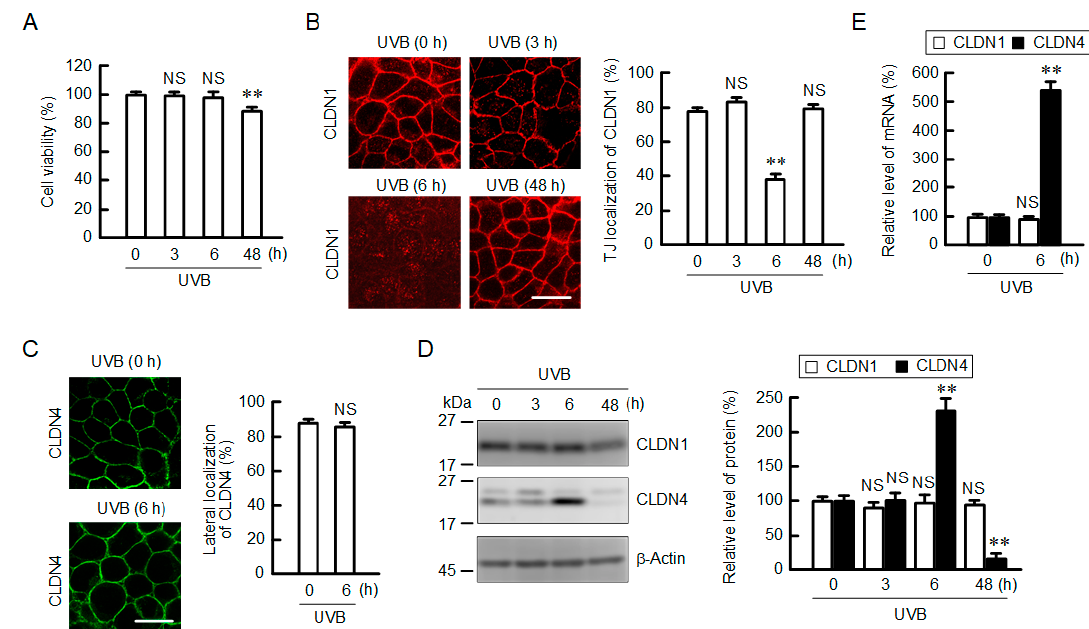
Figure 1. Effect of weak ultraviolet B (UVB) irradiation on cell viability and localization of claudin (CLDN). ( A ) After exposing to weak UVB (5 mJ/cm 2 ), the cells were cultured for 0–48 h. Cell viability was measured using a 2-(4-iodophenyl)-3-(4-nitrophenyl)-5-(2,4-disulfophenyl)-2H-tetrazolium (WST-1) assay. n = 6. (B,C) Cells exposed to UVB were cultured for 0–48 h. The cells were immunostained with anti-CLDN1 antibody ( B ) and anti-CLDN4 antibodies ( C ). Scale bars indicate 10 μ m. The fluorescence values of CLDN1 at the tight junction (TJ) and CLDN4 at the lateral side are shown as a percentage of the total fluorescence values. n = 3. ( D ) Cell lysates were applied to 12.5% SDS-PAGE followed by blotting with anti-CLDN1, anti-CLDN4, and anti- β -actin antibodies. The full-length blot images are shown in Figure S1. The levels of CLDN1 and CLDN4 are represented as a percentage of 0 h. n = 4. ( E ) The expression levels of CLDN1 and CLDN4 mRNAs were measured using real-time PCR. n = 4. ** p < 0.01 and not significant (NS) p > 0.05 vs. 0 h.